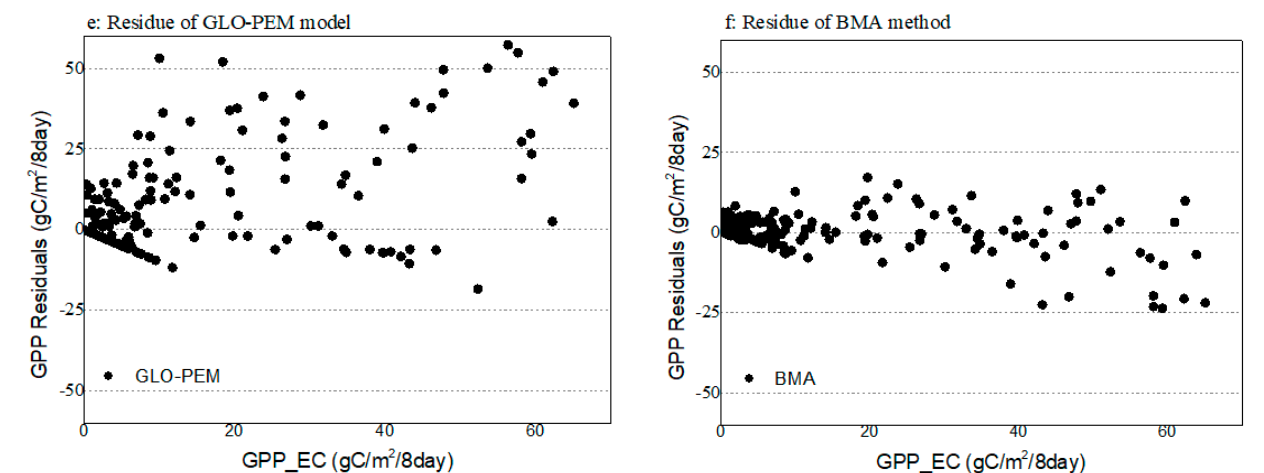
Land 2021 , 10 , x FOR PEER REVIEW 7 of 10